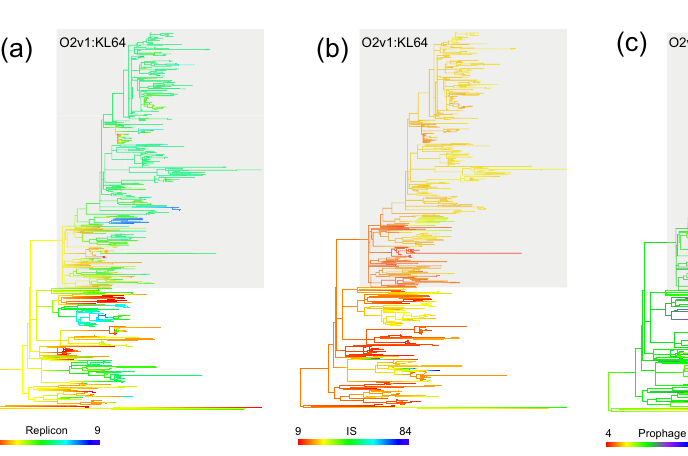
Fig. 4 | Ancestral state reconstructions of MGEs with signi fi cant differences between O2v1:KL64 and OL101:KL47. MGE was mapped as a continuous char- acter onto the phylogenetic tree calculated by the 646 ST11 genomes. Evolution reconstructedwiththeRpackagephytoolsonthedataset,includingthenumberof